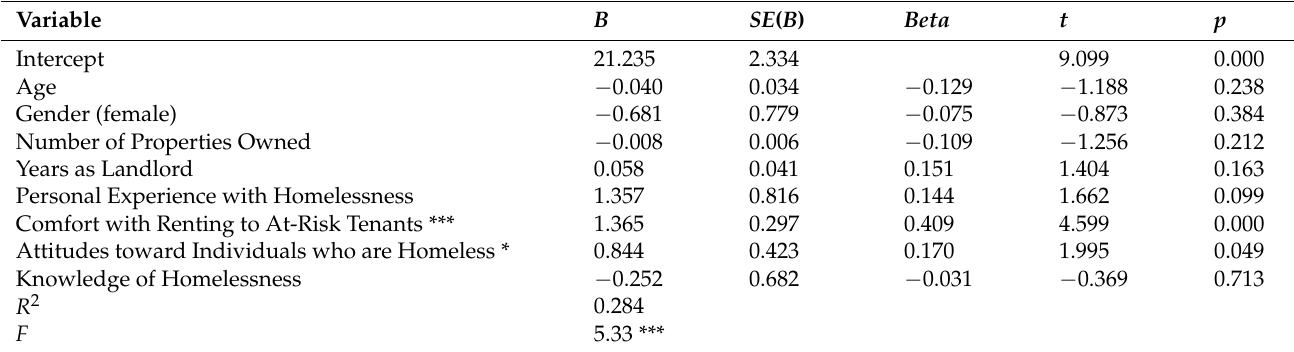
Table 4. Linear regression analysis. This table provides the statistics for the linear regression analysis predicting landlord willingness to rent to individuals experiencing homelessness. Variables in model were verified at Student’s t and all assumptions of linearity and homoscedasticity were met. Multicollinearity was not present, indicated by appropriate VIF values.